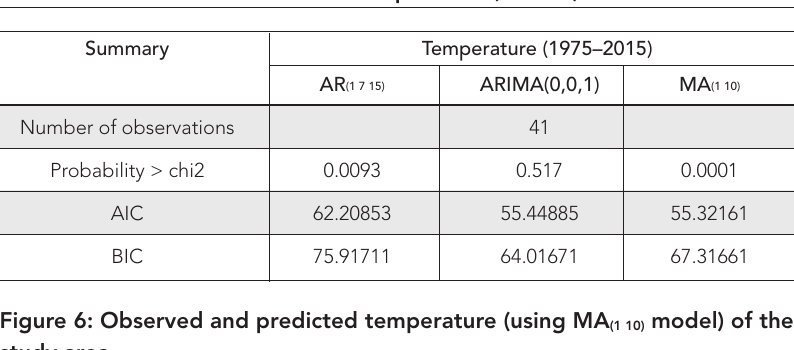
Table 3: Test result of considered temperature (ARIMA) models